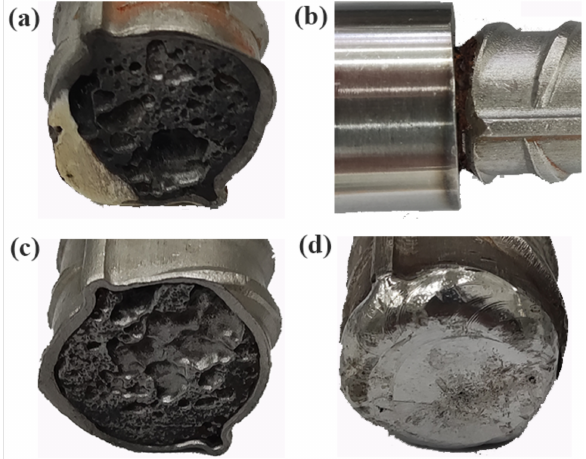
Figure 17. End profiles of reinforcement after descaling: ( a ) end profile with epoxy seal; ( b ) surface profile at sleeve joint; ( c ) end profile without seal treatment; ( d ) end profile with welded